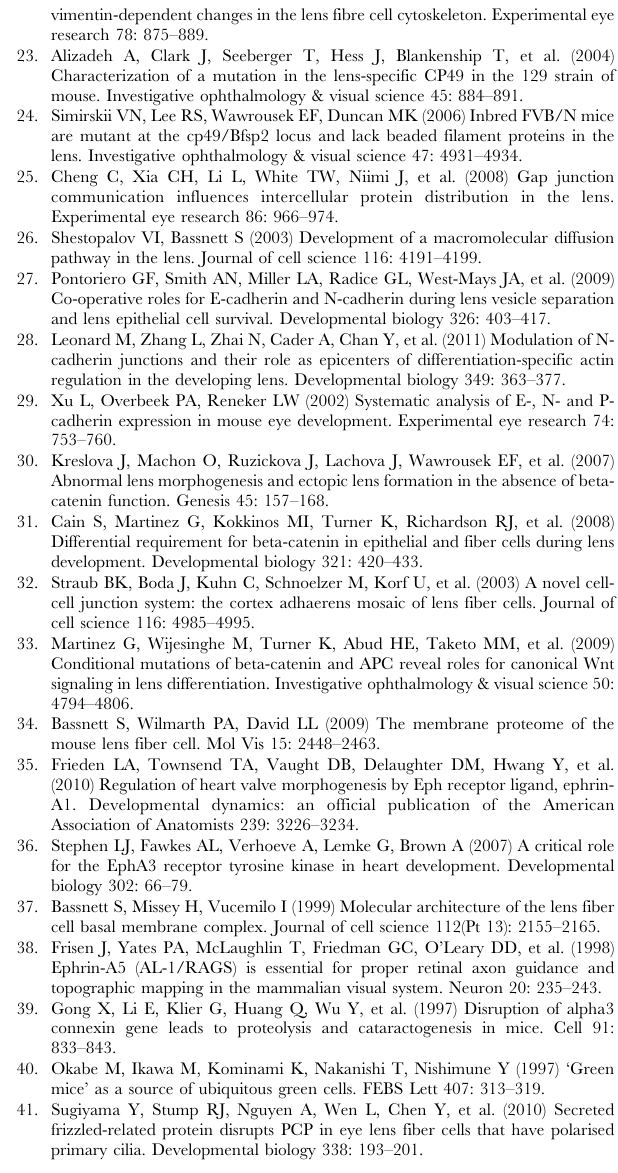
Figure 6. Localization of ephrin-A5 and EphA2 in the lens. Double immunolabeling of ephrin-A5 (red) and EphA2 (green) with DAPI staining (blue, nuclei) of anterior lens epithelial and fiber cells from lens capsule flat mounts of P21 wild-type (WT) and ephrin-A5(-/-), EphA2(-/-) mice (A). Side views of z-stack reconstructions of anterior epithelial cells with underlying fiber cells of P21 WT, ephrin-A5(-/-), EphA2(-/-) lens capsule flat mounts reveal that ephrin-A5 proteins (red) show punctate signals mostly at the lateral and apical sides of lens epithelial cells (EC), and EphA2 proteins (green) show diffused signals in fiber cells (F) (B). Scale bar, 20 m m.